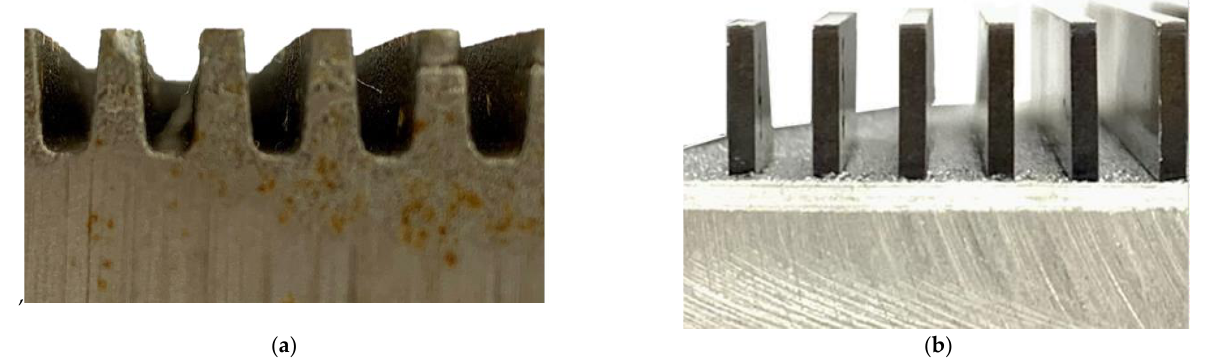
Figure 3. The lateral views of the cast and novel plates: ( a ) The cast plate with a draft angle; ( b ) The novel plate without a draft angle.